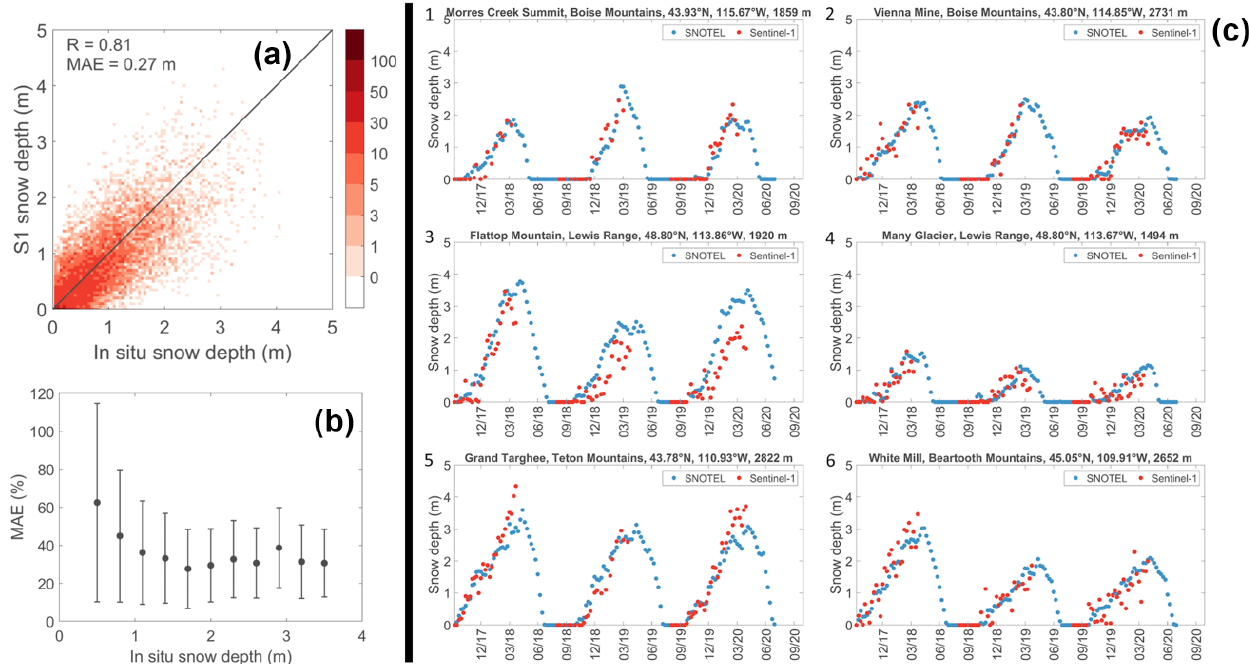
Figure 18. Snow depth retrieval from Sentinel-1, 2017–2020, in Idaho, Montana, and Wyoming. (a) Density plot of weekly 300m resolution S1 snow depth retrievals and coincident SNOTEL observations from 203 sites. (b) The corresponding mean and standard deviation of the absolute error between S1 retrievals and in situ measurements, stratified by the measured snow depth. (c) Time series comparison between snow depth from S1 and SNOTEL in situ measurements at six locations for three winter seasons. Note that the analysis includes snow-free conditions but excludes wet-snow conditions as detected with the S1 algorithm (Lievens et al.,